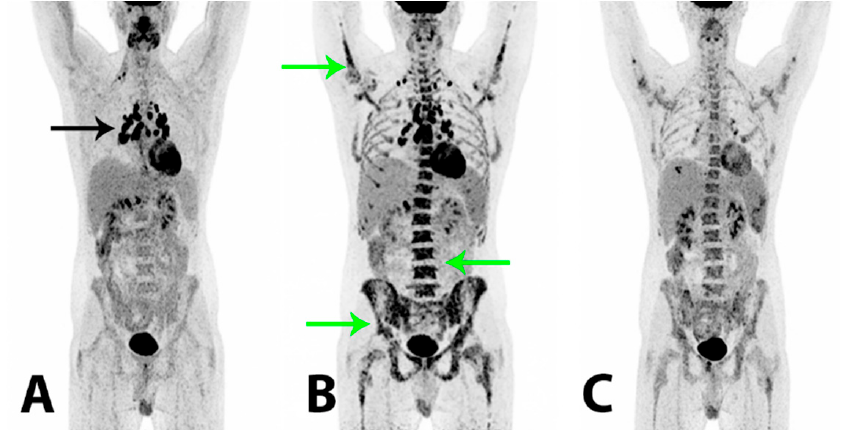
Figure 4. To reduce the risk of HS relapse, an experimental therapeutic approach with high-dose chemotherapy administering a BEAM (carmustine + etoposide + cytarabine + melphalan) regimen and a subsequent autologous stem cell transplant (SCT) was initiated. The patient tolerated the treatment well and at follow-up +60 days after BEAM/SCT the regeneration of bone marrow was considered complete and the tumor marker plasma LDH was still within the reference range (157 U/L). 2-[ 18 F]FDG PET/CT ( A ) demonstrated a metabolic CR and a further morphological PR. There were now relatively symmetrically localized, metabolically active lymph nodes at the right root of the neck, in both sides of the mediastinum and the lung hilum (black arrow), compatible with possible granulomatous inflammation. Two months later the patient reported a gradual worsening of bone pain in the lumbar and pelvic region. The plasma LDH was now elevated (450 U/L) and thrombocyte and hemoglobin levels were low. A relapse of HS was suspected, which was confirmed by a bone marrow biopsy that showed a massive infiltration of almost 100% of malignant histiocytic cells with blastoid morphology and an immunohistochemical profile similar to previous specimens. Findings on 2-[ 18 F]FDG PET/CT ( B ) were compatible with a relapse, demonstrating a heterogeneous, patholog- ically increased FDG-uptake in the bone marrow in the axial and peripheral skeleton (green arrows). There were metabolically active lymph nodes above and now also below the diaphragm. A malignant bone marrow infiltration with a myeloid expansion was considered the cause of the patient’s bone pain. The plasma LDH rose rapidly to 5100 U/L and salvage therapy with an acute myelogenous leukemia regime (CLAG-M; cladribine + cytarabine + mitoxantrone) was initiated. The treatment had a good effect on the patient’s bone pain and wellbeing. The plasma LDH was normalized within days and histopathological examinations showed no tumor cells in the blood and no malignant cells in the bone marrow biopsy. 2-[ 18 F]FDG PET/CT ( C ) demonstrated a metabolic PR of previously malignant findings in the bone marrow. There were now splenic lesions compatible with abscesses. A second course of CLAG-M was administered and, as the patient had achieved a second CR confirmed by a bone marrow biopsy, a non-myeloablative allogeneic SCT was considered. However, within a short period of time the patient again reported bone pain and he developed cutaneous papules on the trunk end lower extremity from which a biopsy showed HS. The plasma LDH also increased rapidly and 2-[ 18 F]FDG PET/CT (not shown) again demonstrated progression with a pathologically increased FDG-uptake in the bone marrow and new metabolically active cutaneous lesions on the abdomen. The findings were compatible with a systemic relapse and an allogeneic SCT was now not a feasible treatment option. Palliative treatment with a modified FLAG-Ida regime (fludarabine + cytarabine + idarubicin + filgrastim) initially had a good effect on the bone pain; the cutaneous lesions regressed and the plasma LDH decreased. However, the effect was short-lived and the patient experienced intermittent fever, bone pain, fatigue and blood cell counts that demonstrated cytopenia. The plasma LDH again increased. The patient’s clinical condition worsened significantly and after short periods of treatment with high-dose cytarabine and hydroxycarbamide, further treatment attempts with intensive regimen chemotherapy were considered futile. No appropriate protocolled treatment was found suitable for the patient and the treatment aim of long term survival was abated. The patient passed away shortly after, 15 months after his initial